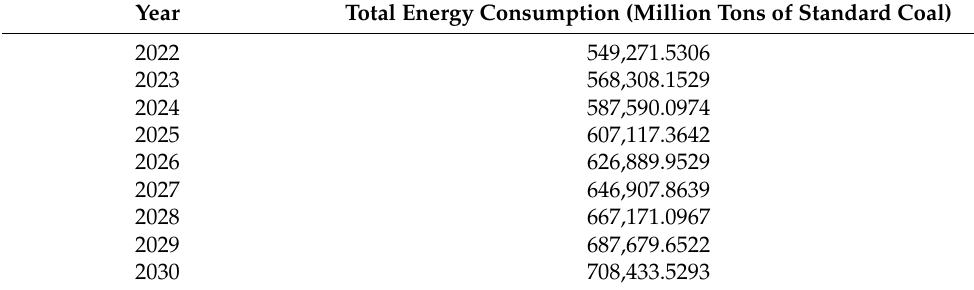
Table 6. China’s total energy consumption forecast from